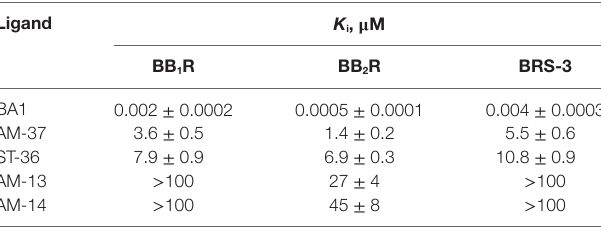
TaBle 1 | Binding to lung cancer cells transfected with human bombesin